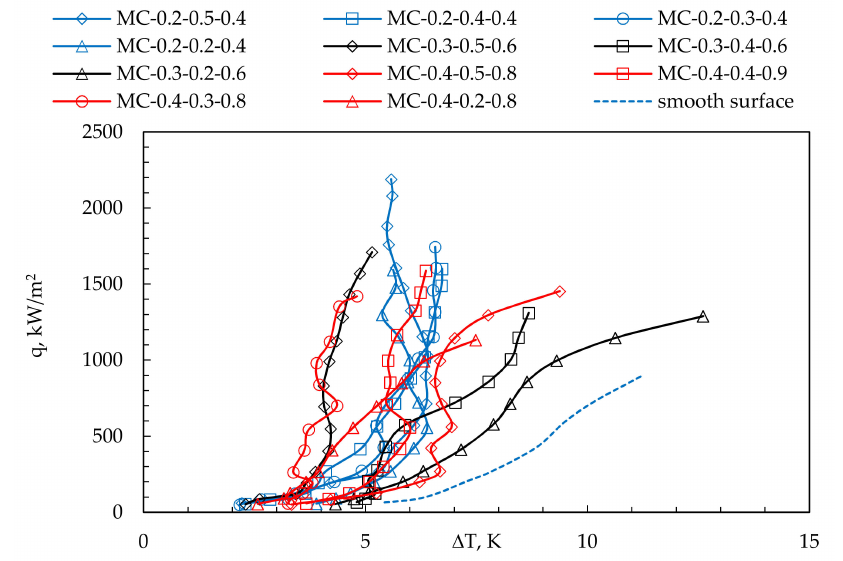
Figure 7. Boiling curves for water: heat flux vs. superheat.